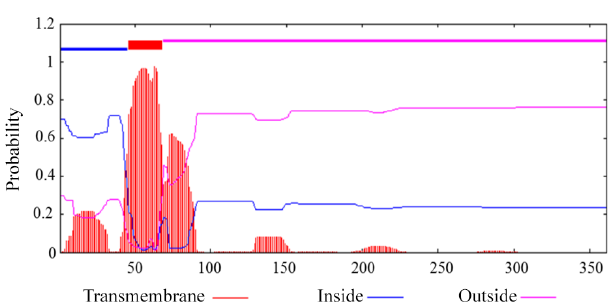
Figure 4. Predicted transmembrane helix in buffalo DGAT2.